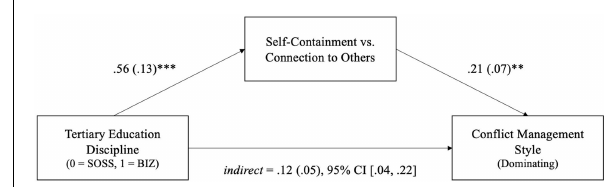
FIGURE 2 | Mediating role of independent self-construal between discipline and competitive conflict management style mediation model with tertiary education discipline (0 = social sciences, 1 = business) as the predictor, self-construal as the mediator, and competitive conflict management style as the outcome variable. All values reflect standardized coefficients and standard errors in parentheses. ** p < 0.01; *** p <